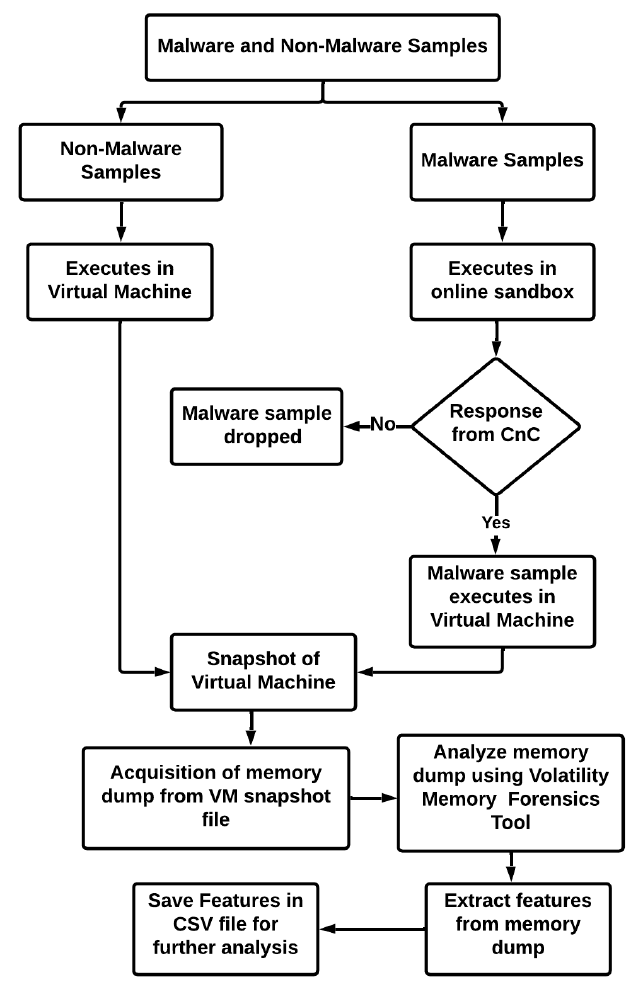
Figure 6. Behavior analysis and features extraction